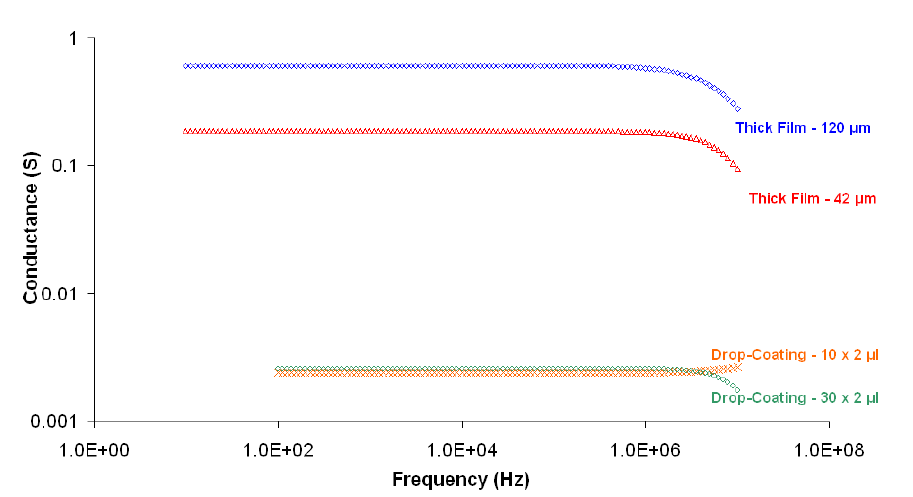
Figure 4. AC electrical characteristics of the various PANI films produced using both drop-coating and thick film deposition, showing conductance values taken over a frequency range of 10 Hz to 10